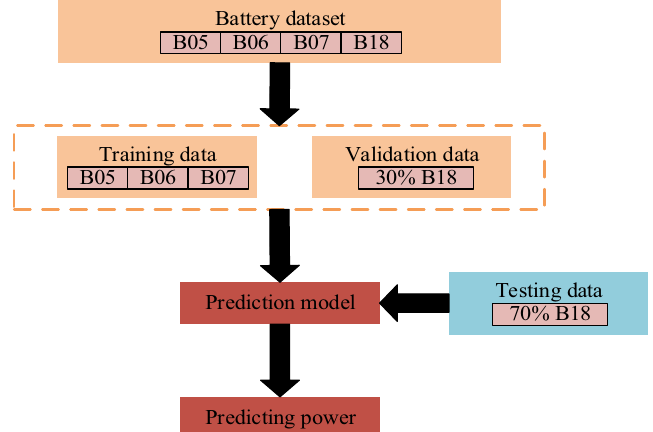
Figure 6. Partition of battery datasets.